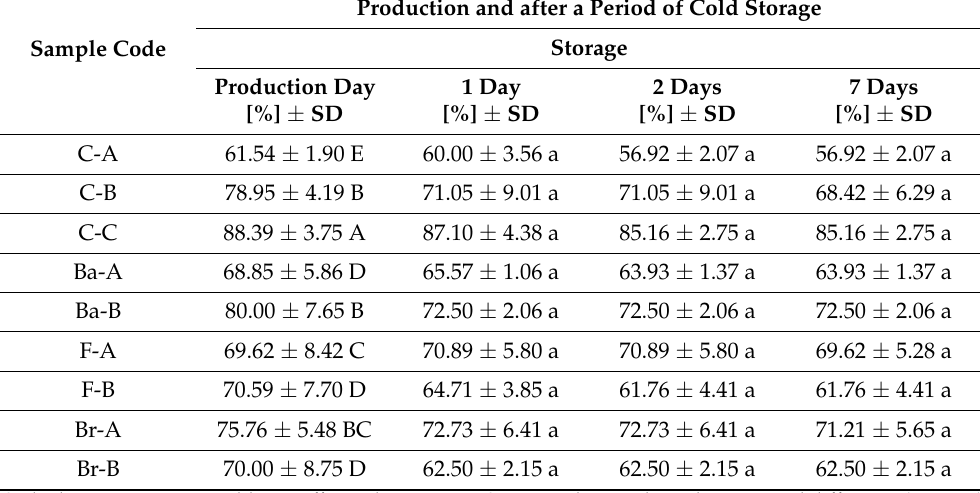
Table 6. Yield of chicken breast fillet